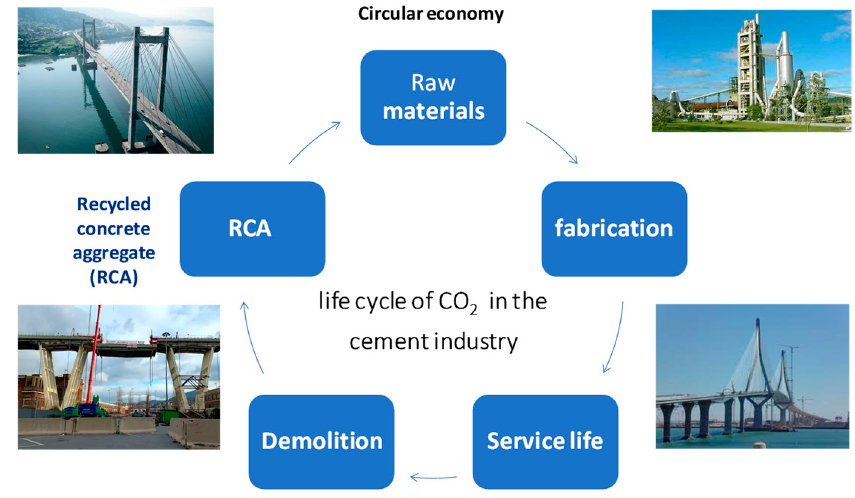
Figure 9. Circular economy in the cement production sector.